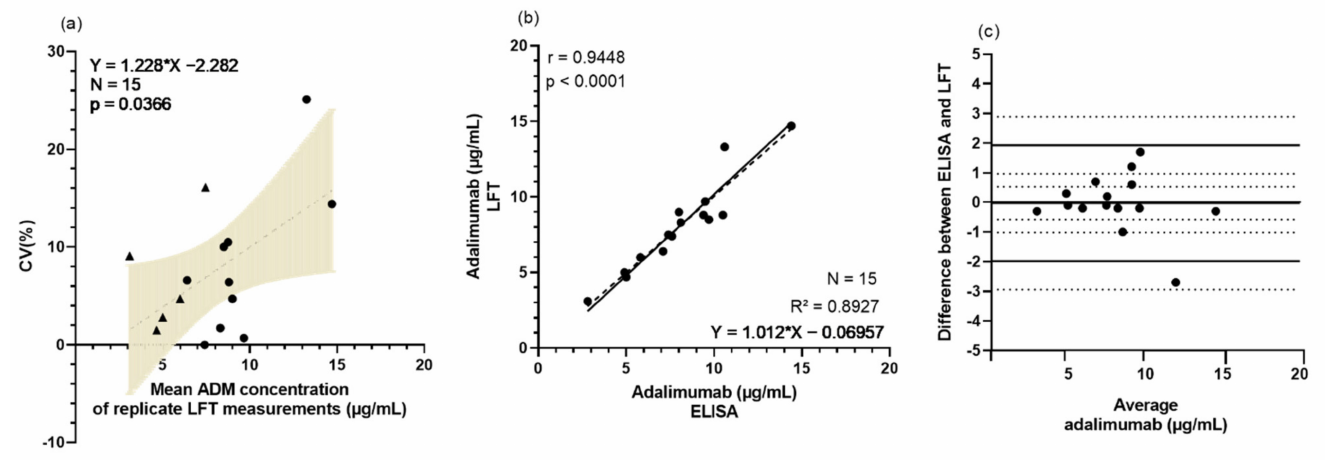
Figure 3. Comparison between LFT and ELISA for quantification of ADM in patient samples from SUPRA-A trial. Serum was collected during ADM maintenance therapy from patients participating in the SUPRA-A trial and drug concentrations were quantified in parallel by two detection methods in duplicate, LFT and ELISA. ( a ) Pearson correlation between the CV (%) and the mean ADM concentrations ( µ g/mL) measured with LFT by 2 independent researchers. Week 0 and week 13 values are represented by circles and triangles, respectively. The grey range indicates the 95% CI of the best-fit line (simple linear regression). ( b ) Pearson correlation between ADM serum concentrations measured with LFT ( Y -axis) and in-house sandwich ELISA ( X -axis). ( c ) Bland–Altman plot for ADM quantification by LFT and with in-house sandwich ELISA. Mean bias and limits of agreement are represented by full lines, 95% CI by dotted lines. Abbreviations: ADM—adalimumab; CI—confidence interval; CV—Coefficient of variation; ELISA—enzyme-linked immunosorbent assay; LFT—lateral flow test; N—number of